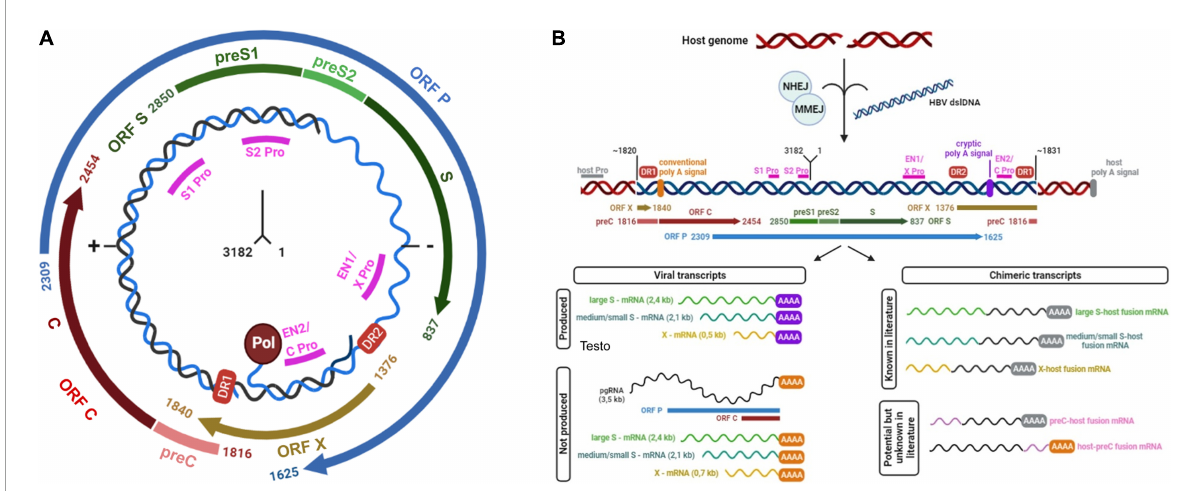
FIGURE1 (A) Schematic representation of HBV genome. HBV genome is represented in relaxed circular form (rcDNA). The numbers at the center of the figure indicate the localization of first and last nucleotides. The four open reading frames or ORFs (S, P, X, C) are depicted. Pol circle indicates viral reverse transcriptase, linked to 3’-end of HBV-DNA. DR1 and DR2 red boxes indicate direct repeat regions 1 and 2: DR1 is present in both strands of HBV-rcDNA while DR2 is present only in the complete negative strand ( − ). Magenta lines show promoters (indicated as Pro) of different ORFs: in particular, enhancer 1 (EN1) acts as promoter of ORF X while enhancer 2 (EN2) acts as promoter for the expression of both ORF C and ORF P. (B) HBV double-strand linear DNA (dslDNA) integrated in host genome and its derived transcripts. The figure depicts the integration of HBV double-strand linear DNA (blue) into the host genome (red). The left-hand side of HBV-dslDNA is expected to be located at or near position 1820 of HBV genome, while the right-hand side at or near position 1831. These sites are not exclusive due to the integration of fragments of viral genome. Magenta lines show viral promoters (Pro), while gray line indicates a generic host promoter (host Pro). Viral open reading frames (ORFs) are depicted. DR1 and DR2 red boxes indicate viral direct repeat regions 1 and 2. Viral conventional poly A signal is showed as an orange bar (nucleotide positions: 1916–1921) while the cryptic poly A signal is represented by a violet bar (nucleotide positions: 1788–1793). The figure reports viral or viral-human transcripts produced from integrated dslDNA. The former derives from the stop of transcription at the site of the cryptic poly A signal, while the latter from the stop of transcription at a human poly A signal. In both panels, the numbering of nucleotides was based on the HBV DNA sequence with Genbank Accession #AB241115—genotype